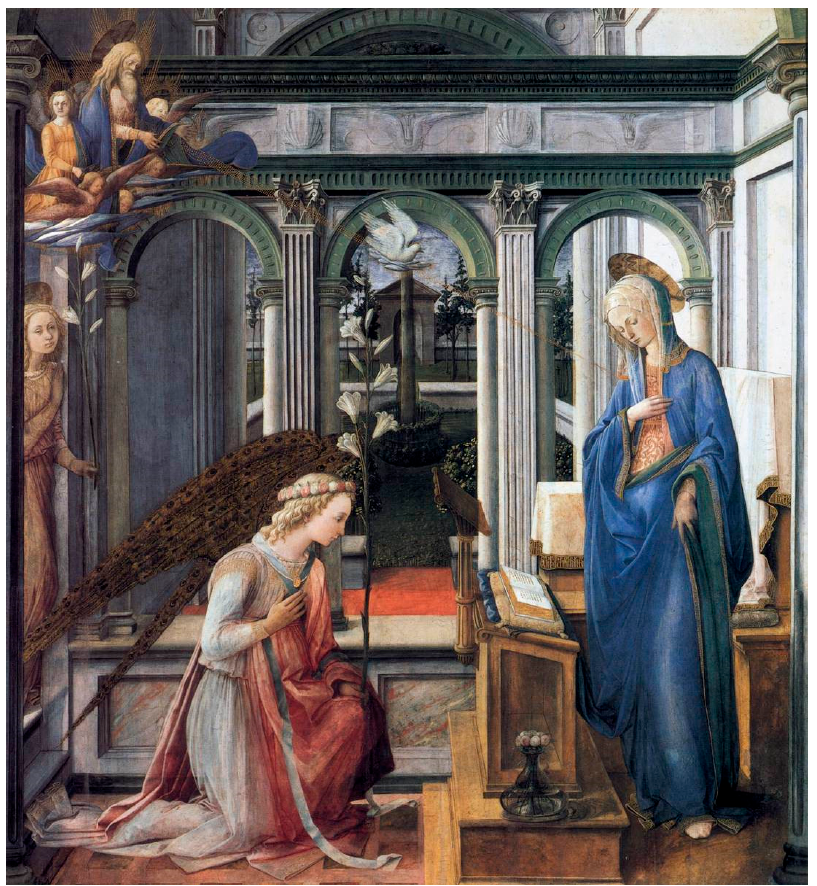
Figure 8. Fra Filippo Lippi, The Murate Annunciation (L’Annunciazione delle Murate) , 1443. Alte Pinakothek, Munich.